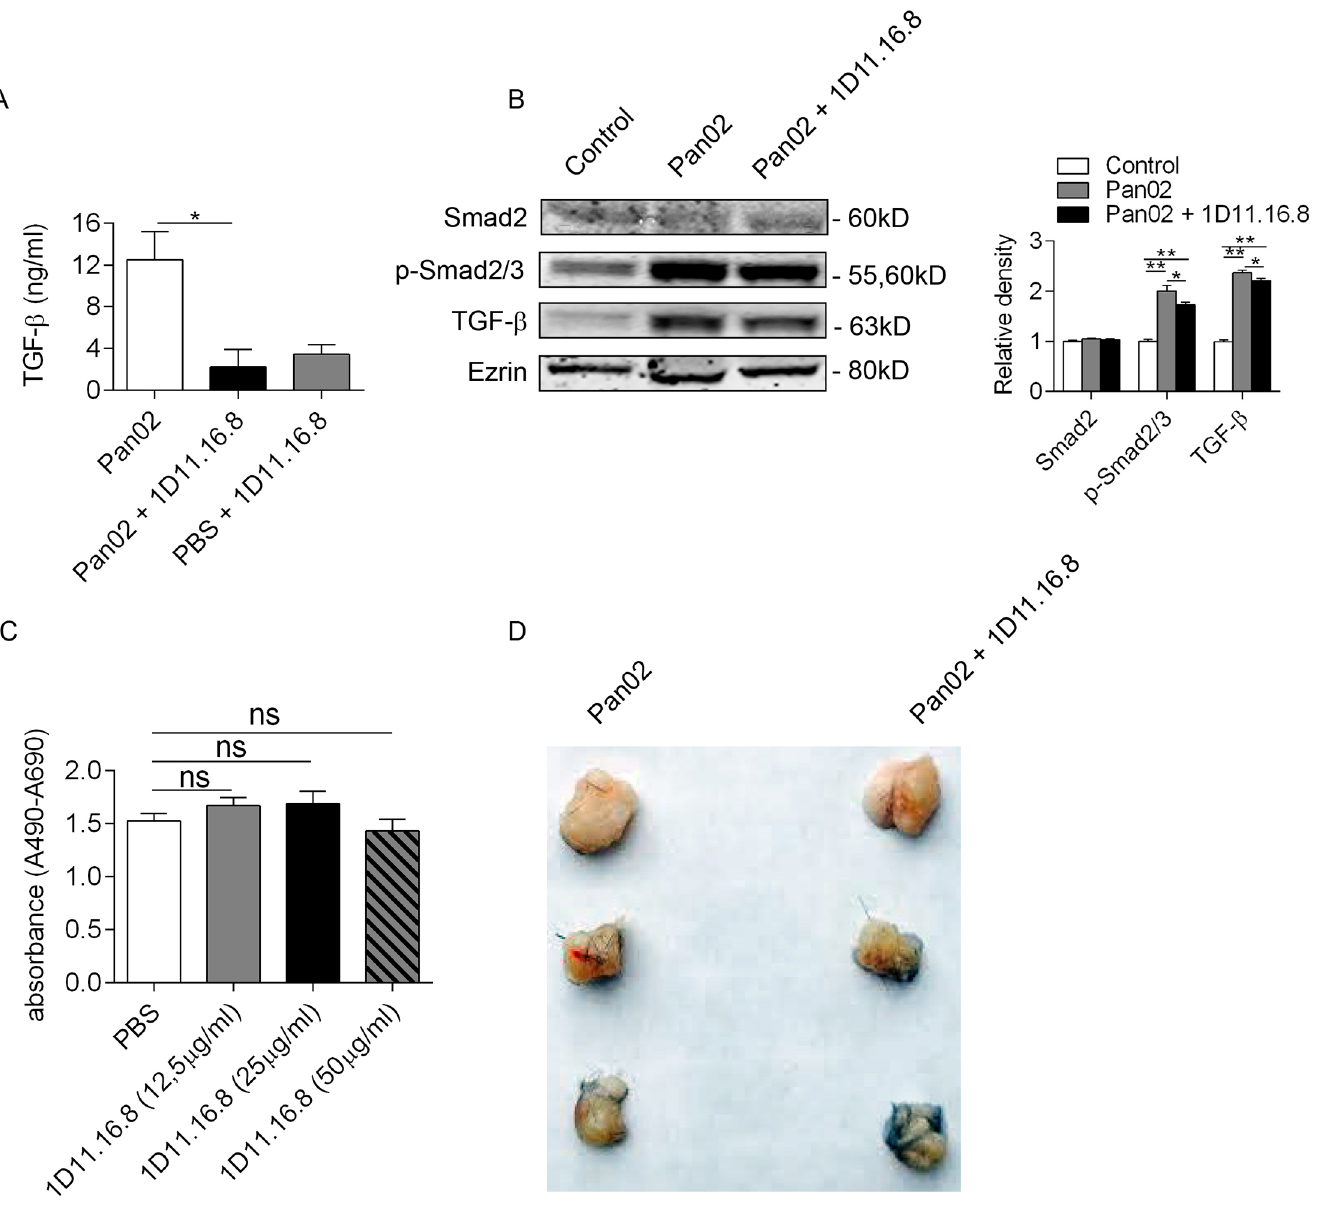
Fig 5. Effects of TGF- β inhibition on pancreatic cancer growth. (A) Serum levels of TGF- β were measured in mice treated with Pan02, Pan02 + 1D11.16.8, or PBS + ID11.16.8 (n = 10/group; * p < 0.05). (B) Intramuscular levels of Smad2, p-Smad2/3, TGF- β , and Ezrin (a loading control) were calculated by Western blotting. Density analysis was done based on triplicates ( * p < 0.05, ** p < 0.01, *** p < 0.001). (C) Pan02 cell proliferation was measured after treatment with increasing doses of 1D11.16.8. (D) 10 7 Pan02 cells were implanted subcutaneously into the right flank of mice treated with either PBS or 1D11.16.8. Tumors were measured twice weekly by caliper and explanted tumors were compared for tumor size (n =